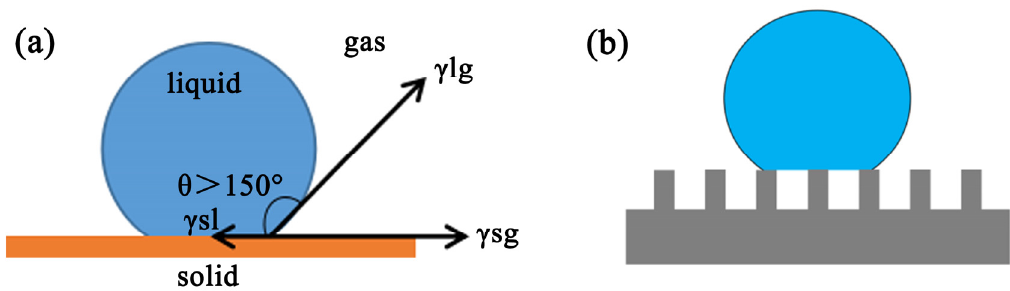
Figure 1. ( a ) Schematic of a superhydrophobic surface, ( b ) Cassie–Baxter